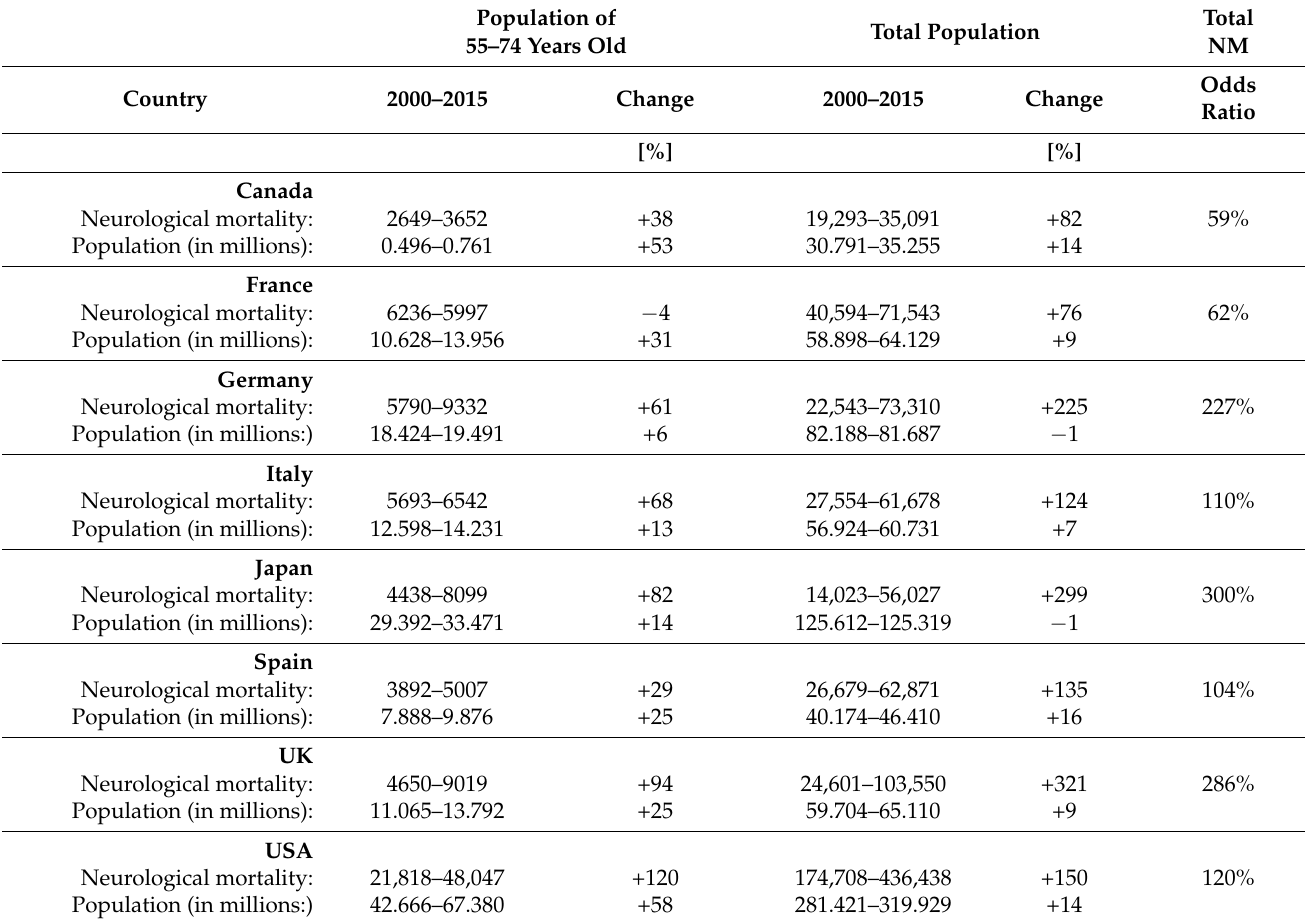
Table 3. Comparison the population of people aged 55–74 and the total populations of the eight largest analysed developed countries (actual numbers, both sexes, neurological mortality, population (in millions)). Odds ratios (OR) of total population to neurological mortality (NM). Based upon WHO [26] data. Population of Total 55–74 Years Old